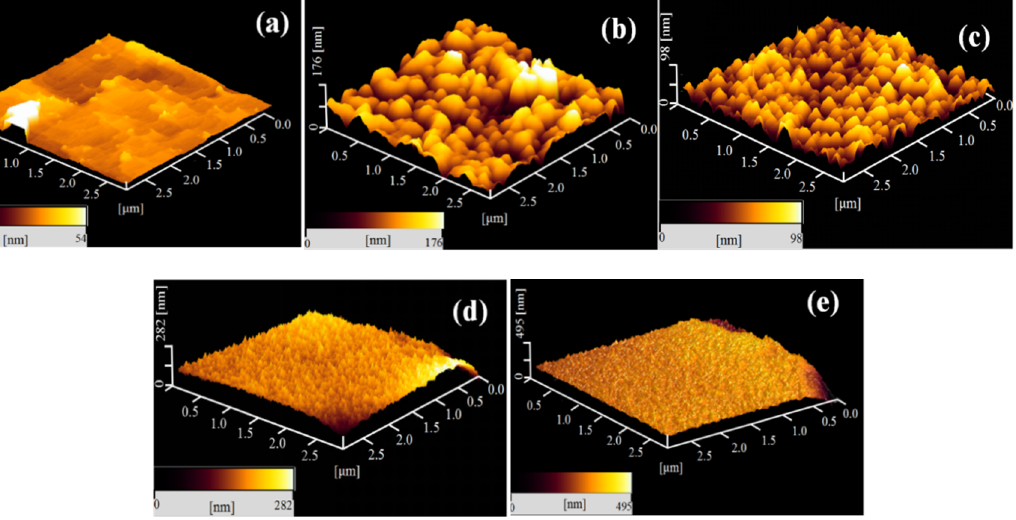
Figure 4. The AFM images of the CL-20/HMX cocrystal and MF coating composites: ( a ) CL-20/HMX cocrystal; ( b ) CH@MF–2; ( c ) CH@MF–3; ( d ) CH@MF–4; ( e ) CH@MF–5. Table 1. Surface roughness parameters of the CL-20/HMX cocrystal and CH@MF composites. Samples CL-20/HMX